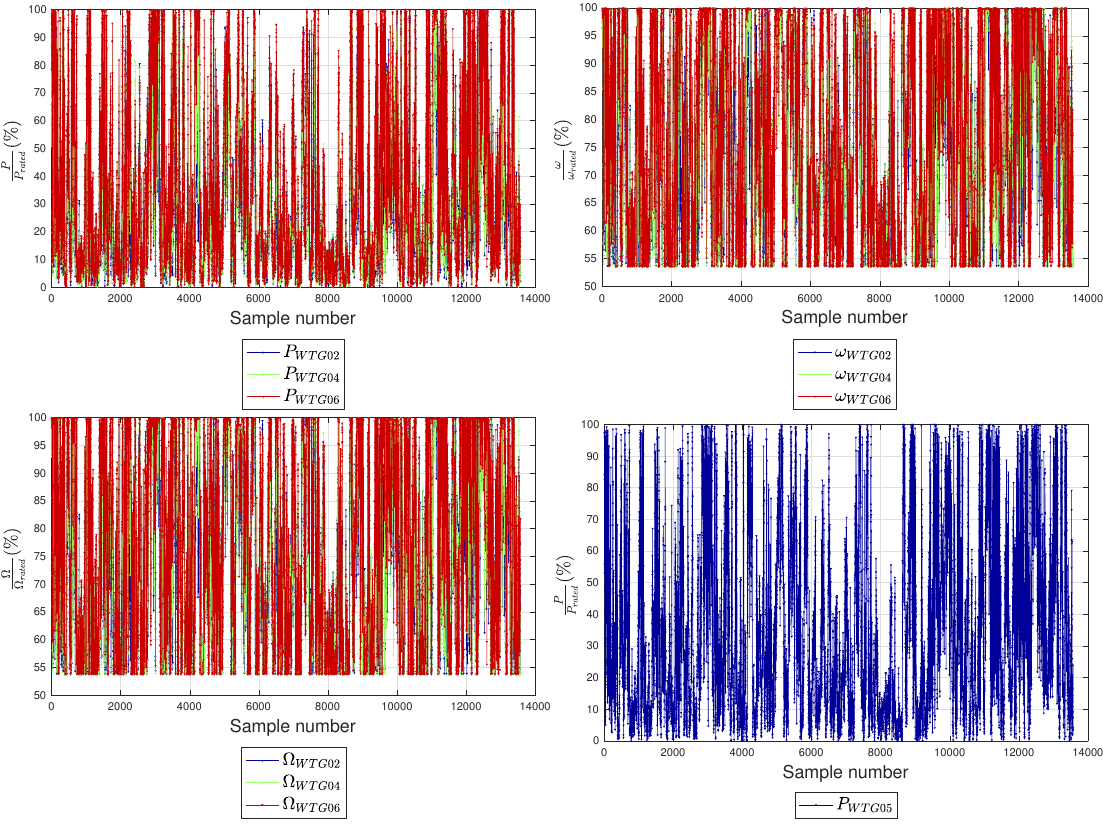
Figure 3. Time series representation of the D bef data set: from the upper left to the lower right, respectively the powers, the rotor speeds, the generator speeds of the reference wind turbines, the power of the target wind turbine WTG05. All the measurements are represented in units of the